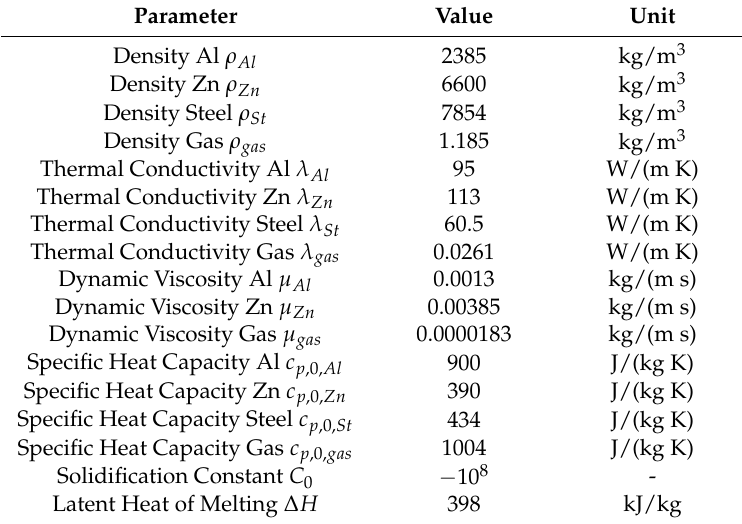
Table 1. Material and model